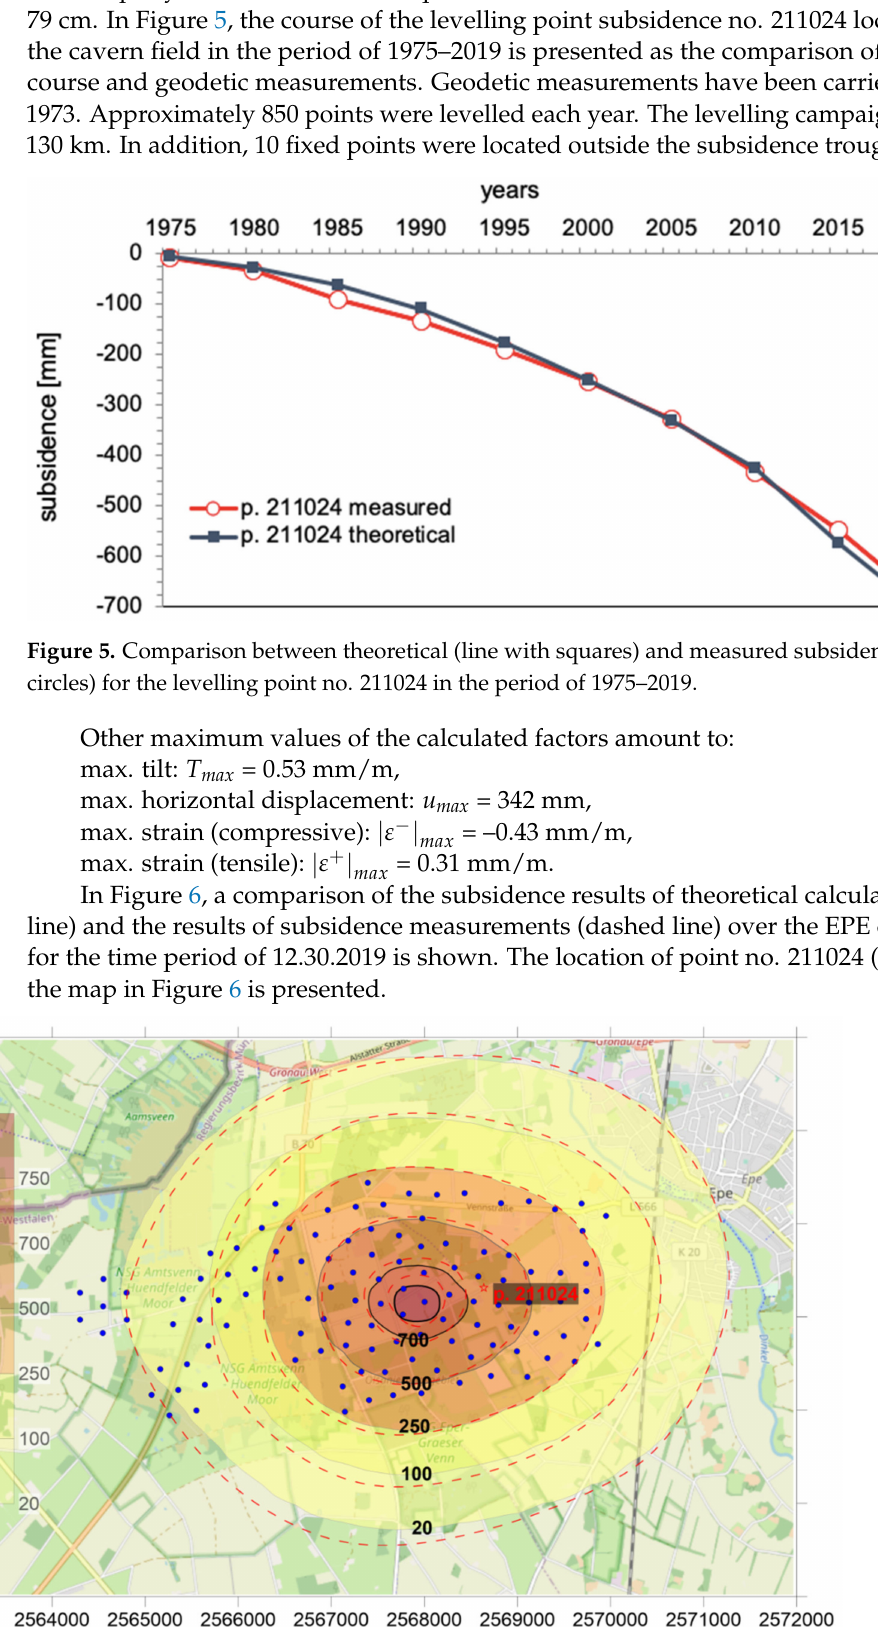
Figure 6. Comparison of the subsidence results of theoretical calculations (solid line) and the results of subsidence measurements in mm (dotted line) over the EPE cavern field, as per 12.30.2019 (the blue circles represent